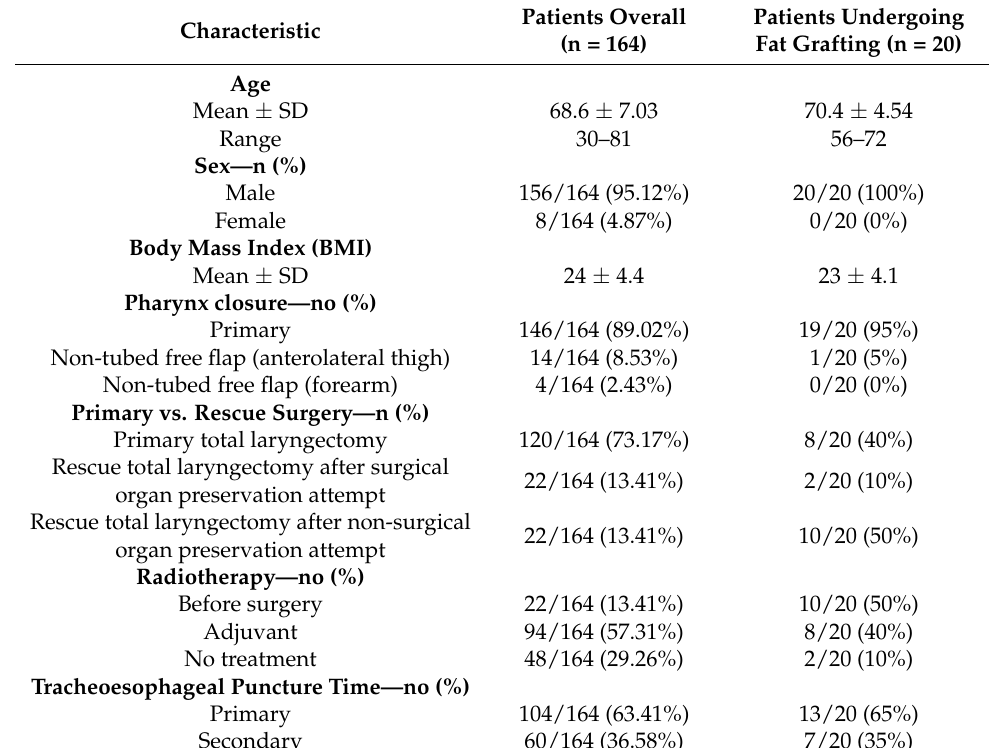
Table 1. Demographic